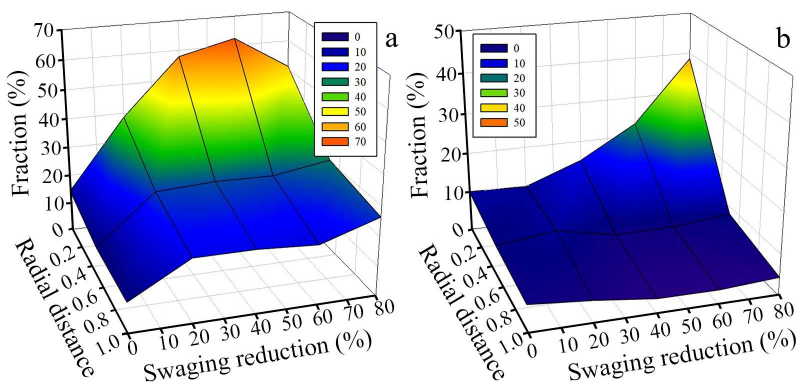
Figure 4. Effect of swaging reduction on the distribution of the volume fraction of grains with ( a ) the 111 ǁ RA and ( b ) 001 ǁ RA texture components.